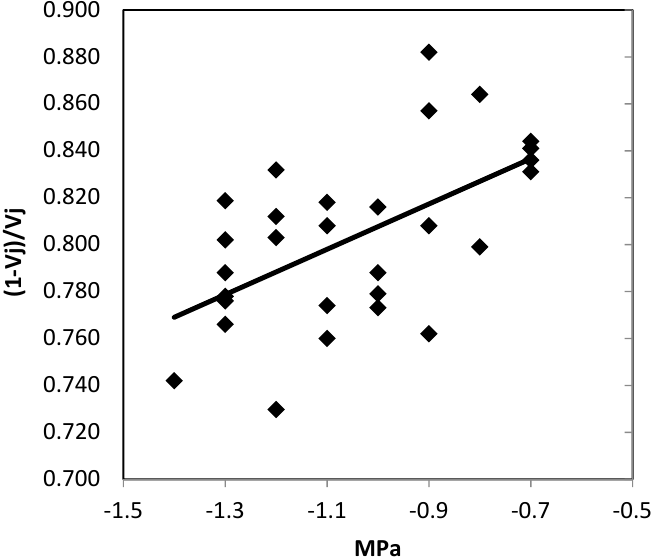
Figure 4. Summer pre-dawn water potential versus summer bark (1 − Vj)/Vj in Ficus macrophylla . Trend line = linear regression, p = 0.001, r 2 = 0.325, n = 29.